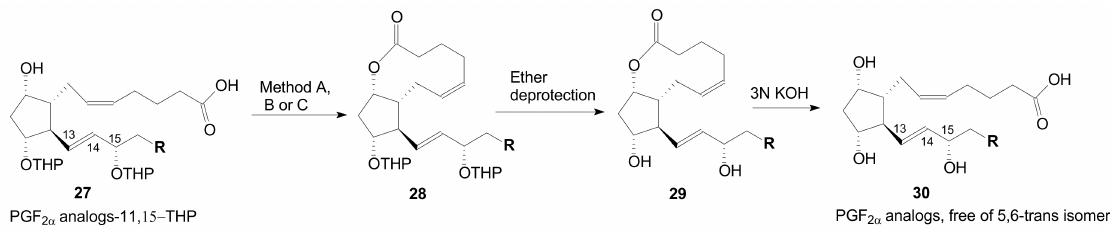
used as a step for obtaining the corresponding prostaglandins substantially free of the 5,6- trans isomer (Scheme 5). Latanoprost, isopropyl unoprostone, travoprost, and tafluprost, and their free acid forms are not solids to be purified by crystallization. The patent is based on the fact that the 1,9-lactones of travoprost, tafluprost, latanoprost, bimatoprost, and unoprostone [26] are crystallized compounds and, by isolation and crystallization of 11,15- or 11-unprotected hydroxyl lactones, the ratio of 5,6-trans isomer obtained is below 0.1%. The lactonizations were performed by the Corey-Nicolaou procedure (entries 1, 6, 8, and 9 in Table 1), but other methods, described below, were also used for the lactonization.